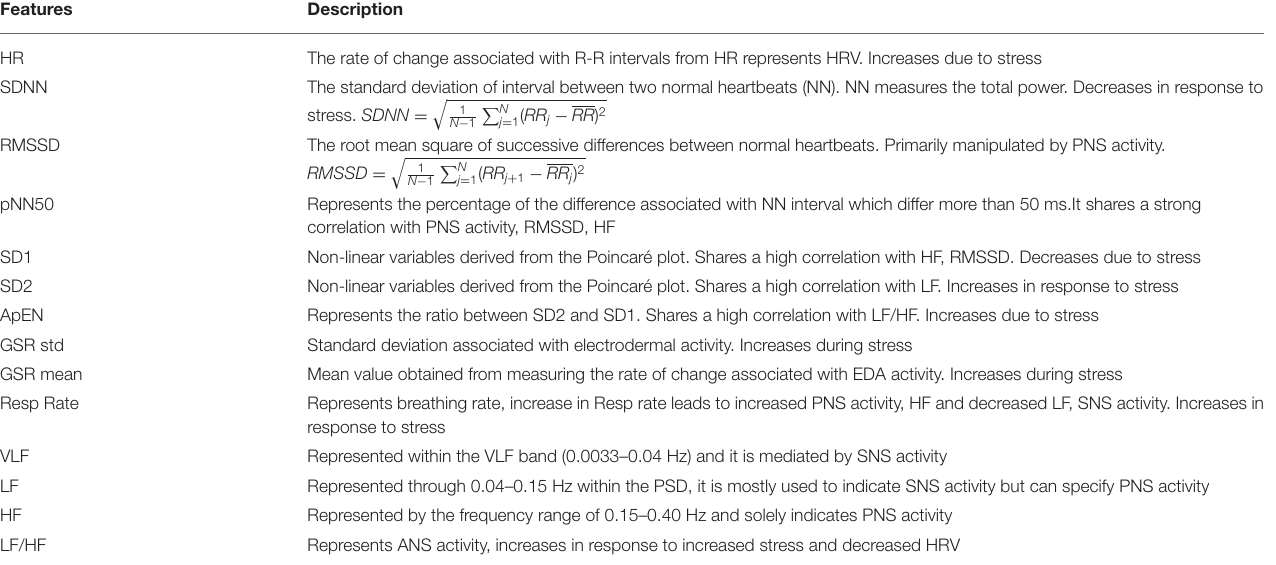
TABLE 3 | Time and frequency domain features.